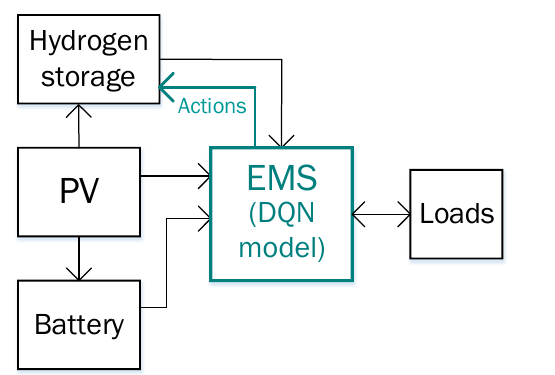
Fig. 7. Schema of the MG featuring PV panels associated with a battery, a hydrogen storage and diesel unit device.